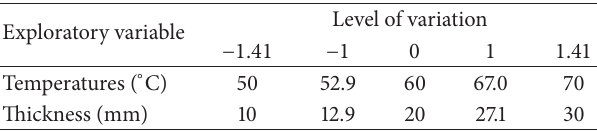
Table 4: Coded values and corresponding actual values used in the second experimental design.